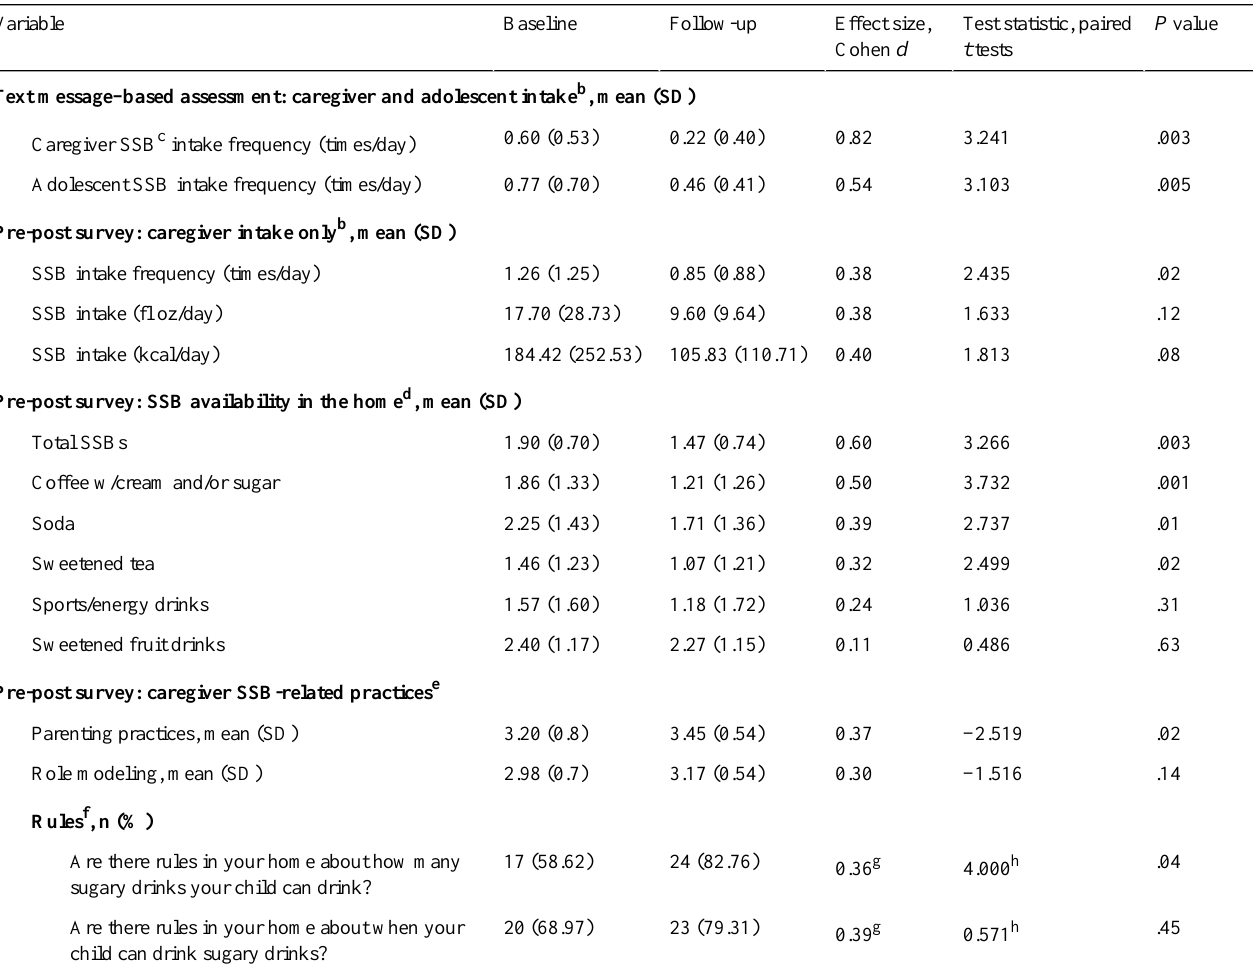
Table 3. Sugar-sweetened beverage intake and behavior change from text message–based assessment and pre-post survey (n=29 a ).